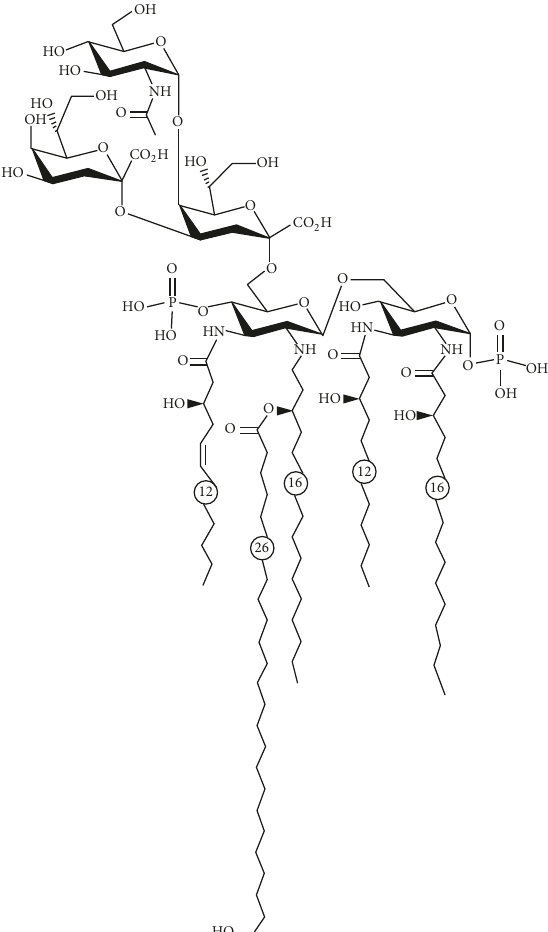
Figure 3: Proposed structure of LOS from Bartonella quintana